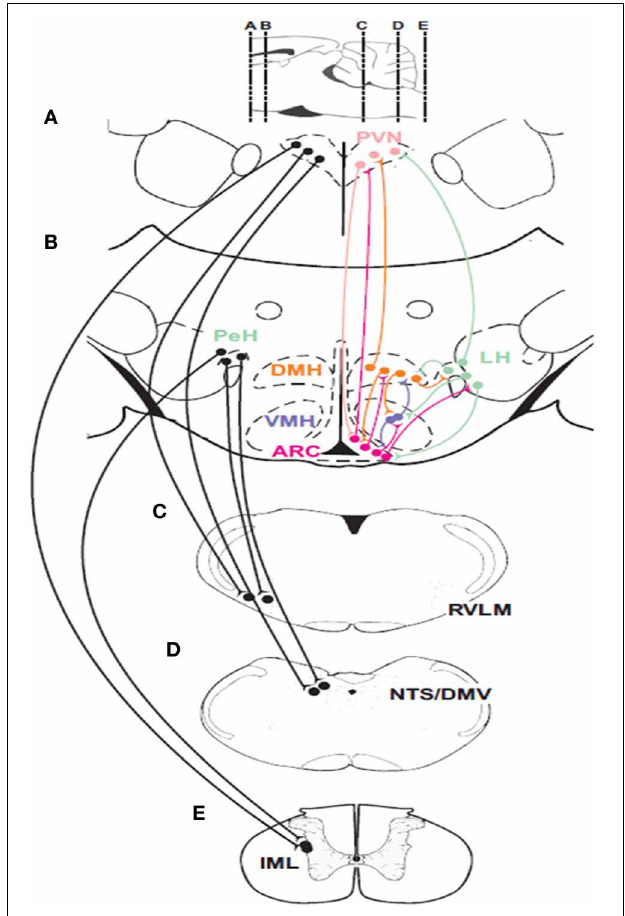
FIGURE 2 | Descending connections and intrahypothalamic pathways involved in glucose homeostasis. Neurons in the paraventricular nucleus of the hypothalamus (PVN) and the perifornical region of the hypothalamus (PeH) have connections with important premotor sympathetic and parasympathetic neuronal groups located in the rostral ventrolateral medulla (RVLM) and the dorsal motor nucleus of the vagus (DMV) as well as to the major sensory relay structure the nucleus of the solitary tract (NTS) and sympathetic preganglionic neurons (SPNs) located in the intermediolateral cell column (IML) of the spinal cord. Glucose-sensing neurons are found in the ARC, the ventromedial hypothalamic nucleus (VMH) and the perifornical region (PeH) of the lateral hypothalamic (LH) area. Parasympathetic efferents to the pancreatic islets can activate insulin and glucagon secretion while C1 neurons in the RVLM provide drive to adrenal SPNs. Parasagittal section at the top of the figure indicates rostrocaudal locations of coronal sections (A–E)